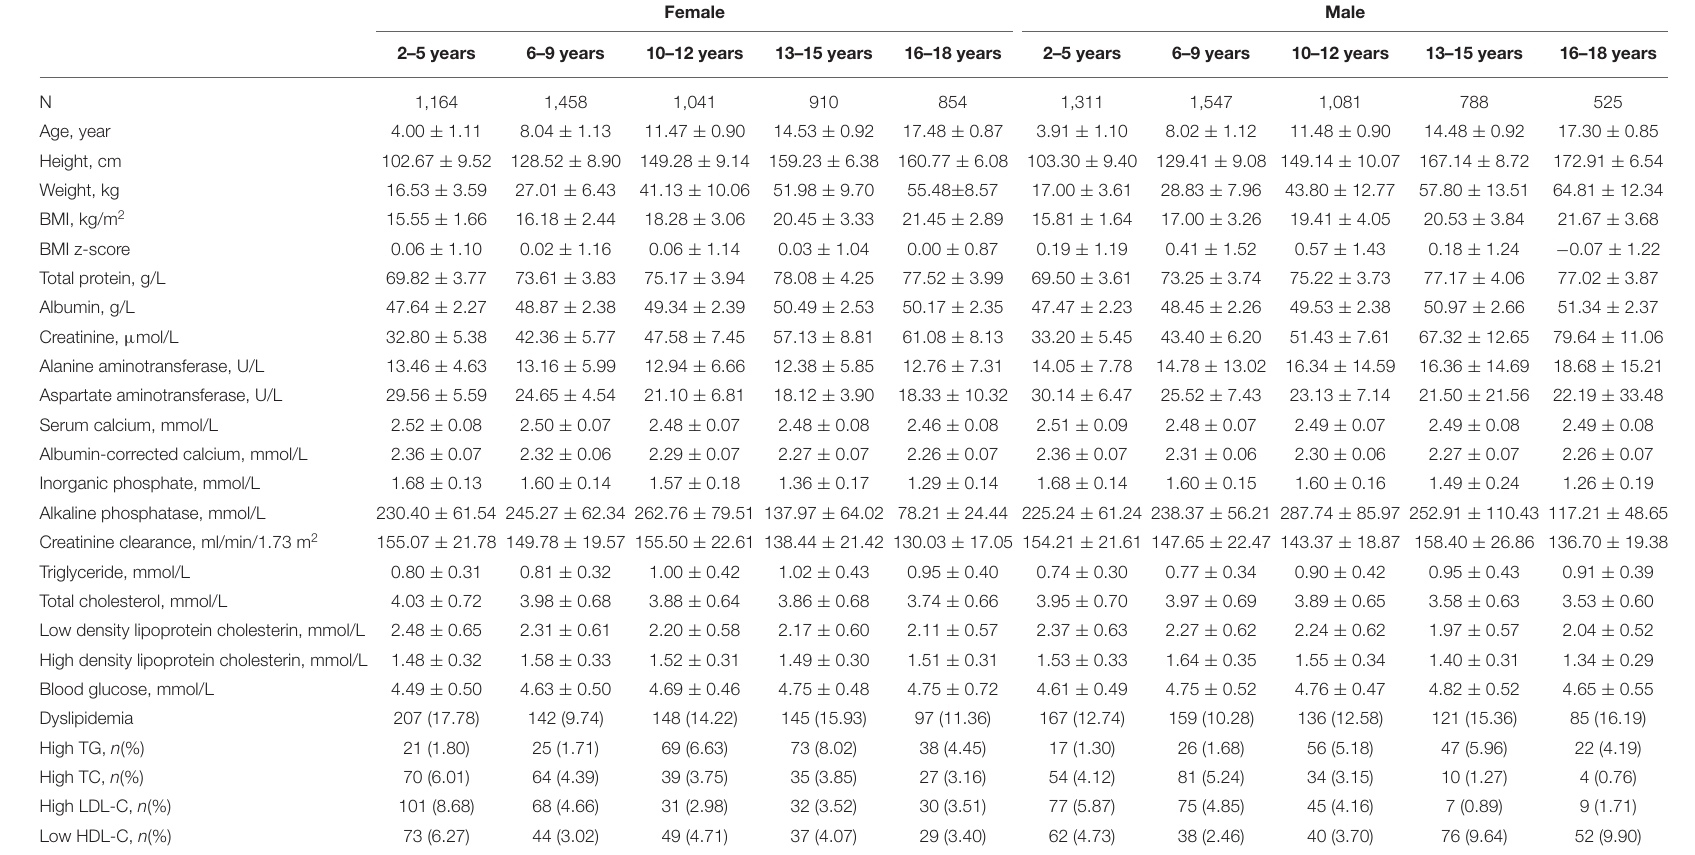
TABLE 1 | Characteristics of the study population ( n = 10,679).